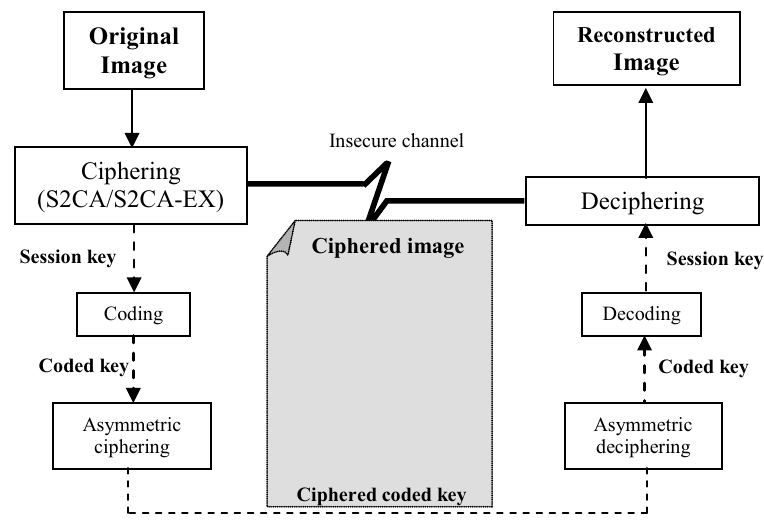
Fig. 16. General scheme of the ciphering process and generated key secure transmission by public